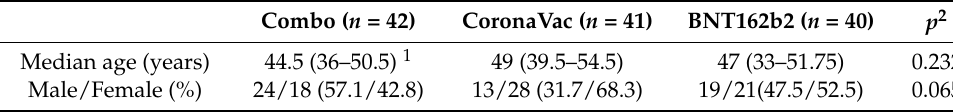
Table 1. Demographic and clinical baseline